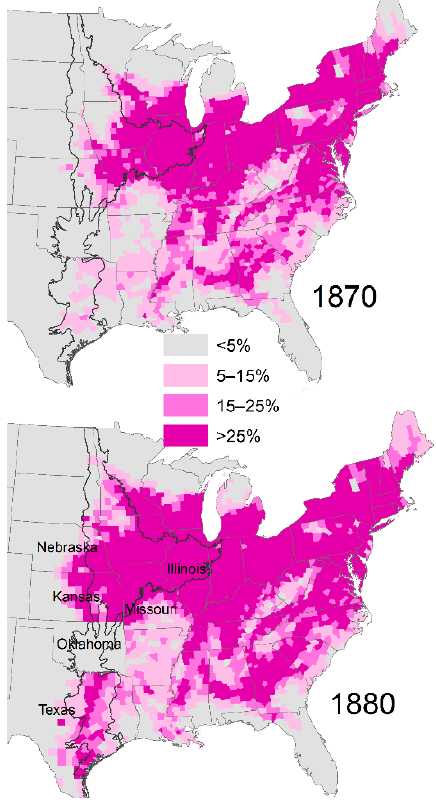
Figure 4. Area in agriculture in 1870 and 1880 (modified from [21]).